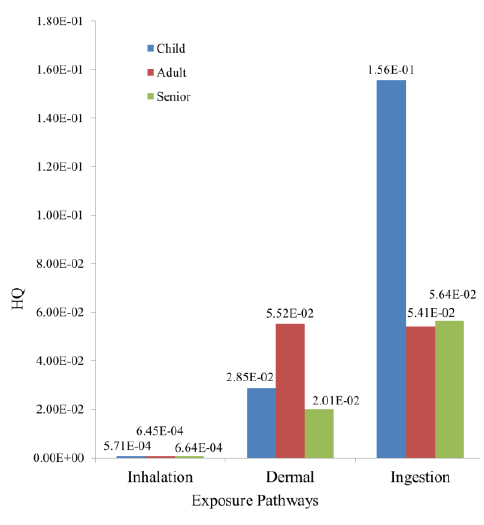
Figure 4. Hazard quotients (HQs) of different age groups under different exposure pathways.